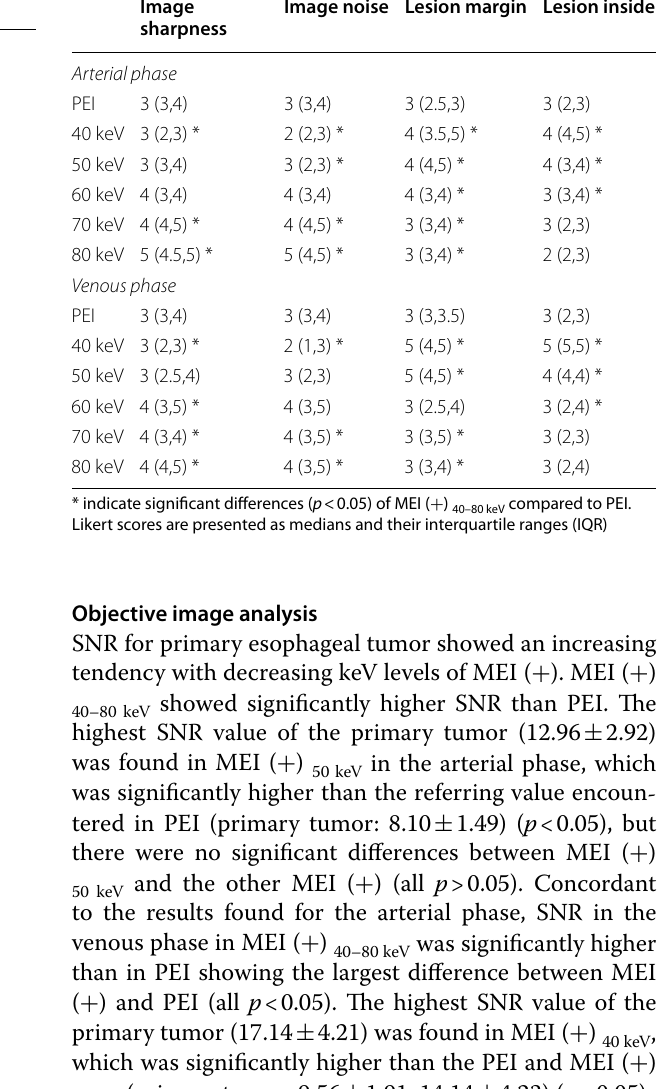
Table 2 Results of the Likert scores on PEI and MEI (